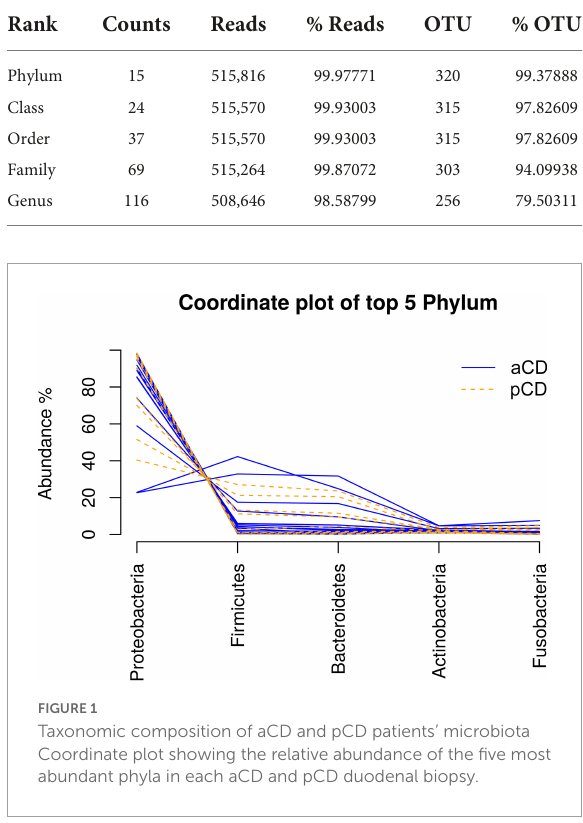
TABLE 2 Summary of the taxonomic analysis of the obtained OTUs.